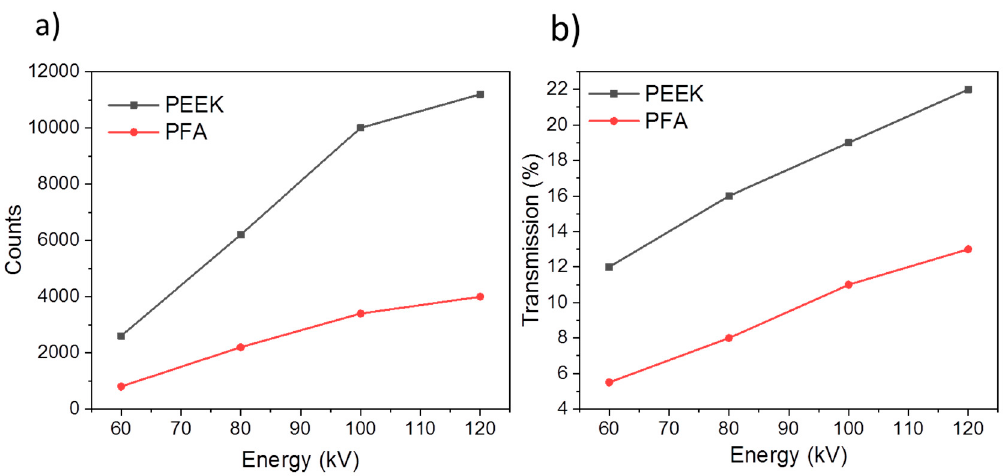
Figure 1. ( a ) Detector counts and ( b ) transmission as a function of source voltage for a 60 s exposure time through an NMC111 electrode in the PFA and PEEK cell.